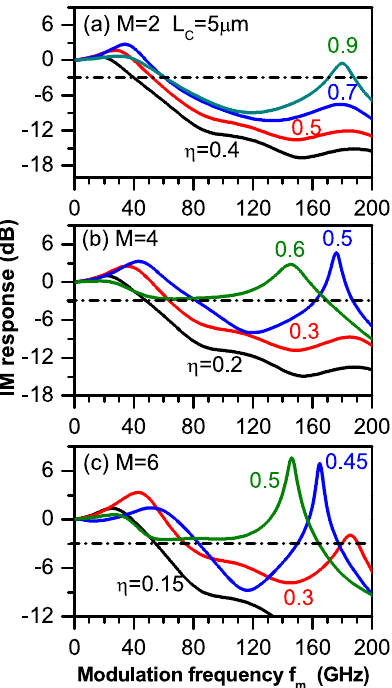
Figure 6: IM response of the design of (a) 2TCC-VCSEL, (b) 4TCC-VCSEL,and(c)6TCC-VCSELwith L C =5 μ matdifferentvaluesof η that results in MBW